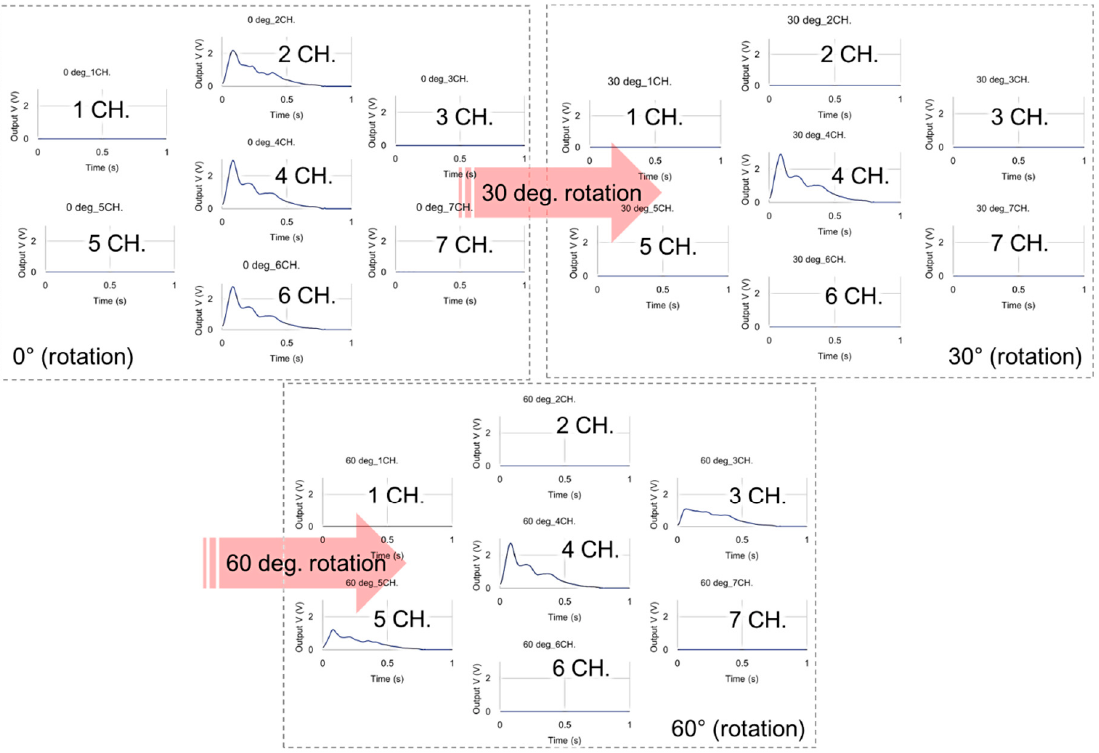
Figure 11. Average waveform of the pulse signal obtained from each channel according to PSRP rotation.